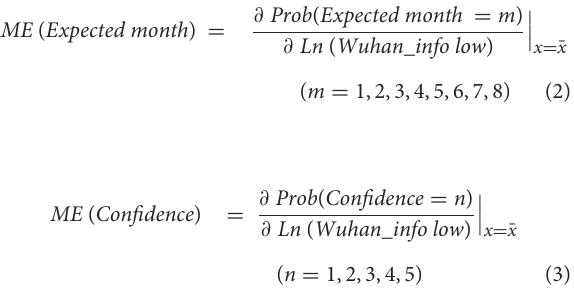
Table 1. The values of expected month ranged from 1 to 8, and